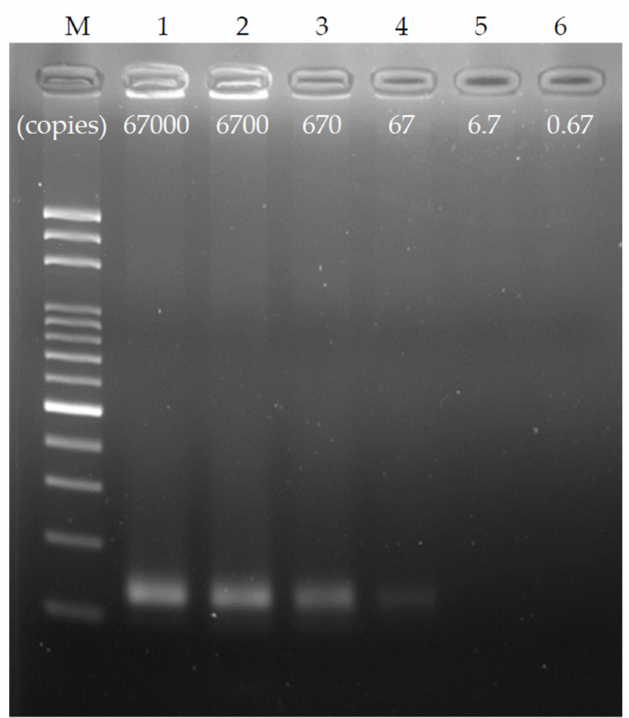
Figure 7. Ultrafast PCR detection limit; the original concentration of 67,000 copies of the sample was diluted with a 10-fold sequence and tested with a flow rate of 6 s/cycle. It was found that the detection limit under this PCR condition was approximately 67 copies, which was equivalent to 40 thermal cycles at 95 ◦ C for 2 s and 72 ◦ C for 4 s in the water tank via manual